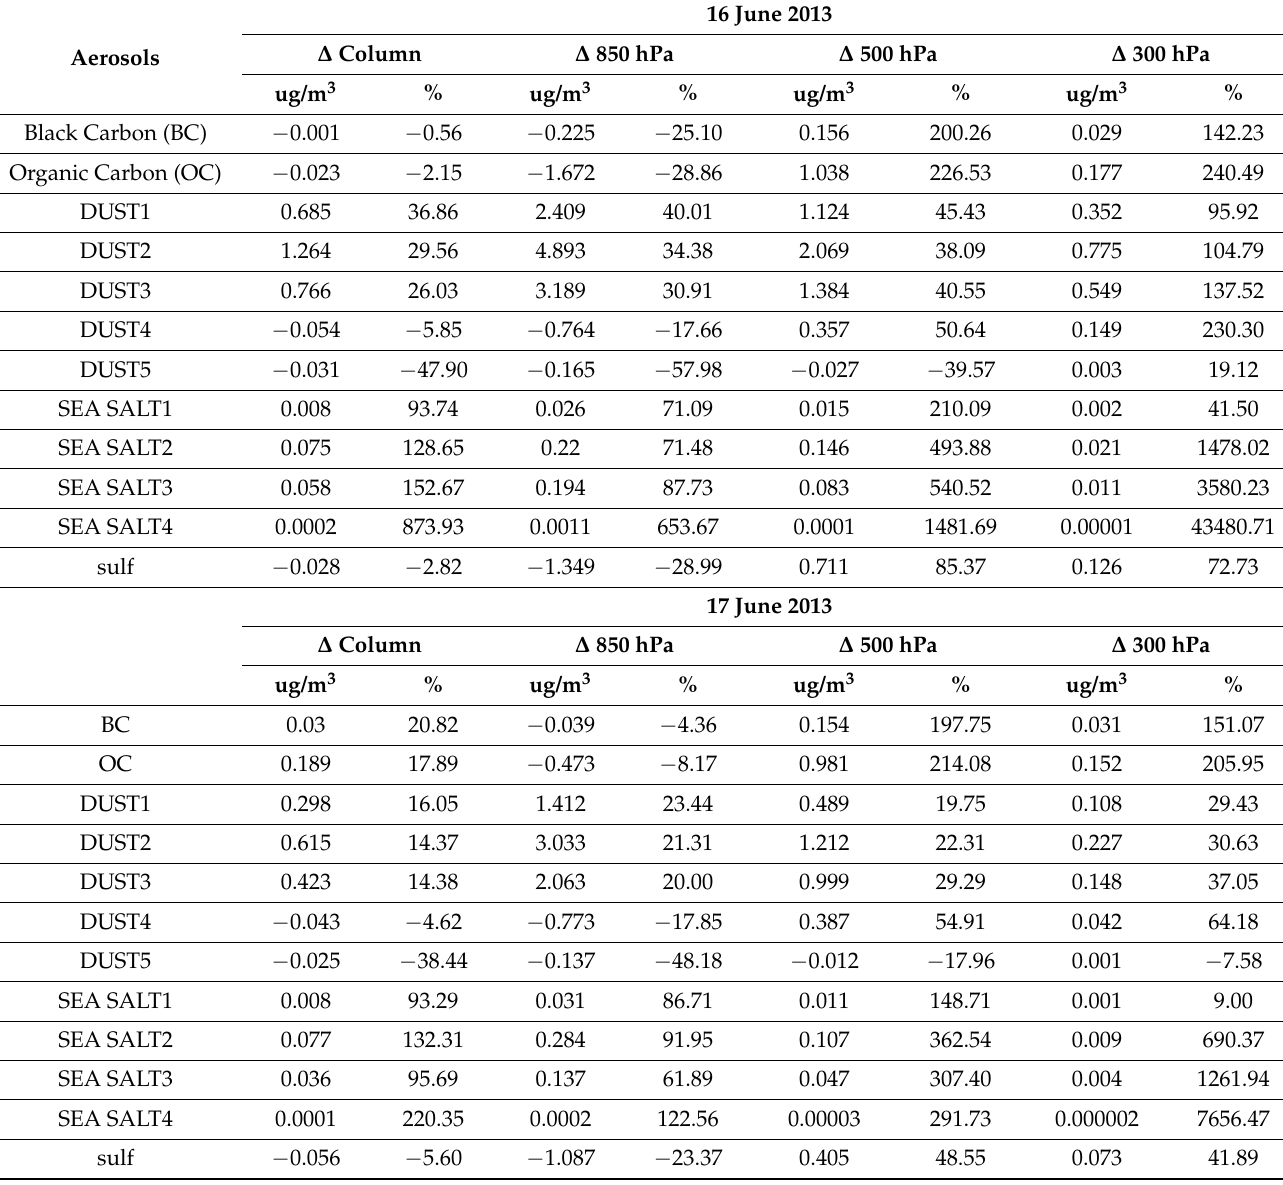
Table 2. ∆ concentration for different aerosols and ∆ in absolute percentage in model column and at 850 hPa, 500 hPa, and 300 hPa for 16 and 17 June 2013 over Kedarnath at 25 km